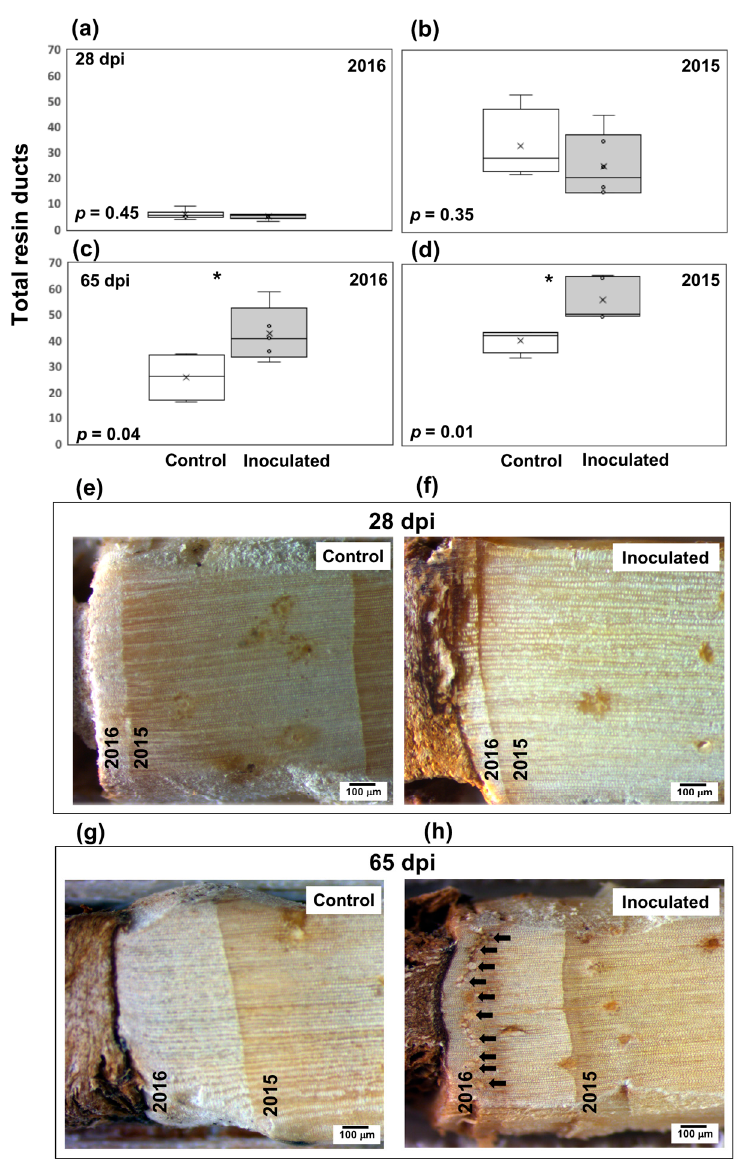
Figure 3. Resin duct counts from the last two growing years of P. strobus at 28 ( a , b ) and 65 ( c , d ) dpi during 2016 and 2015 respectively. Values were averaged across the four cardinal points. Significant differences are indicated by an asterisk; boxes show median and 1st and 3rd quartiles, and whiskers indicate 1.5 inter-quartile range. ( e – h ) Core samples (5 mm wide) of non-inoculated control and O. minus inoculated trees at 28 (top panels) and 65 (bottom panels) dpi. Black arrows show traumatic resin ducts at 65 dpi. Magnification 1.6 × . Scale bar 100 m.